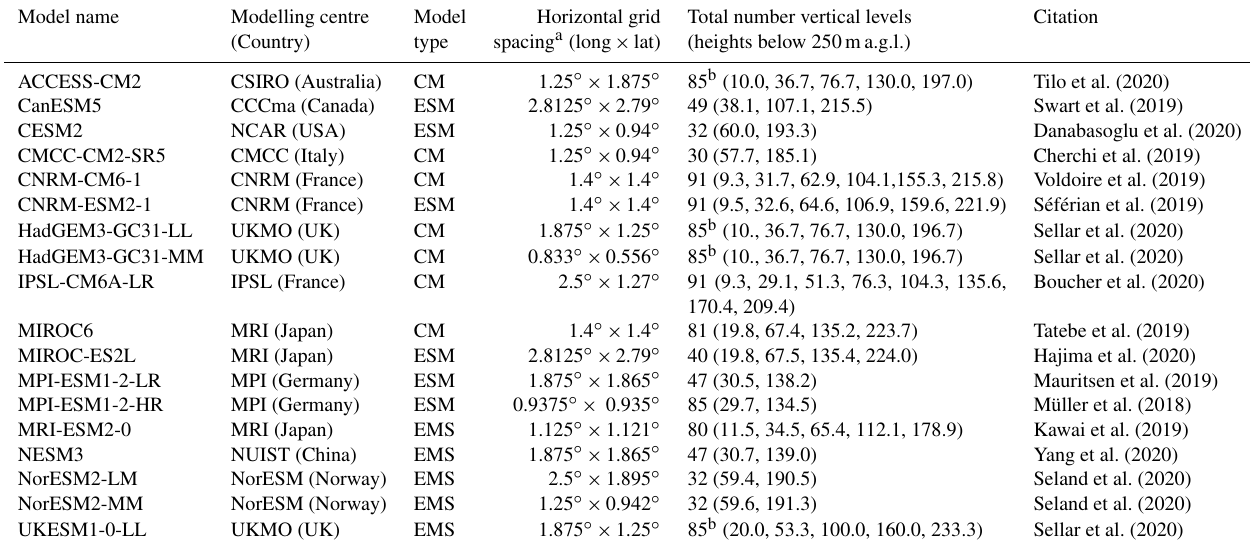
Table 1. Models in the CMIP6 archive with u , v , T , and q available at model levels and 6-hourly output in the historical and SSP5-8.5 simulations. CM stands for climate model, and ESM stands for Earth system model.